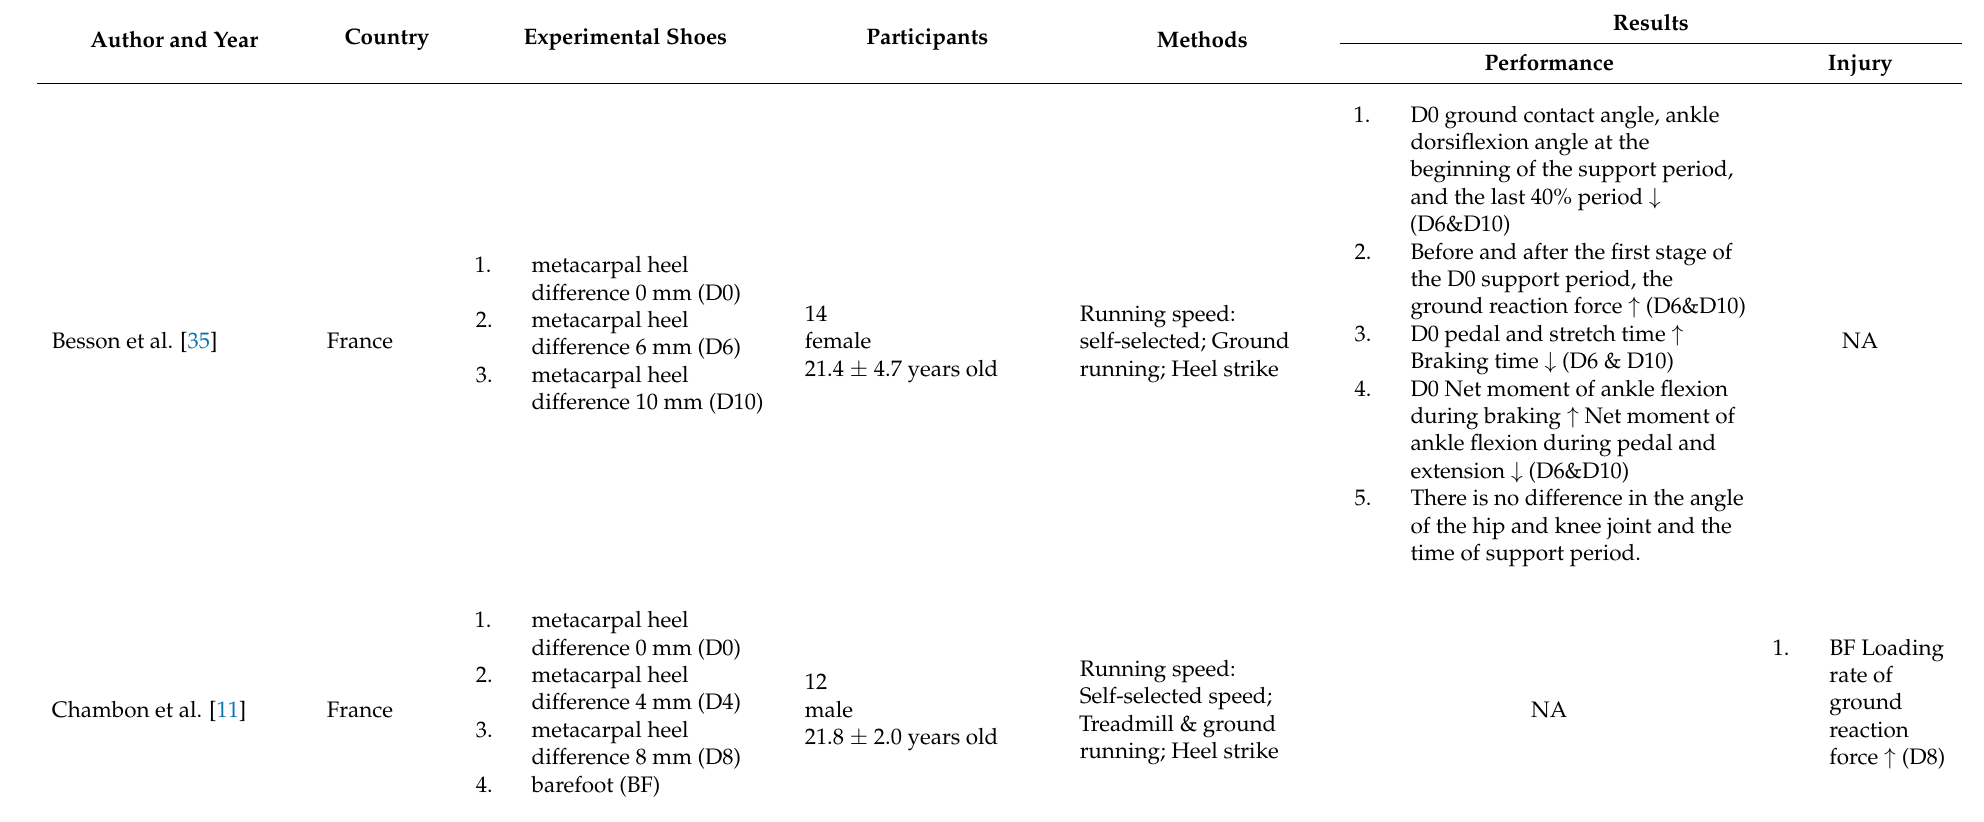
Table 3. The influence of running shoes heel-toe drop on running performance and related